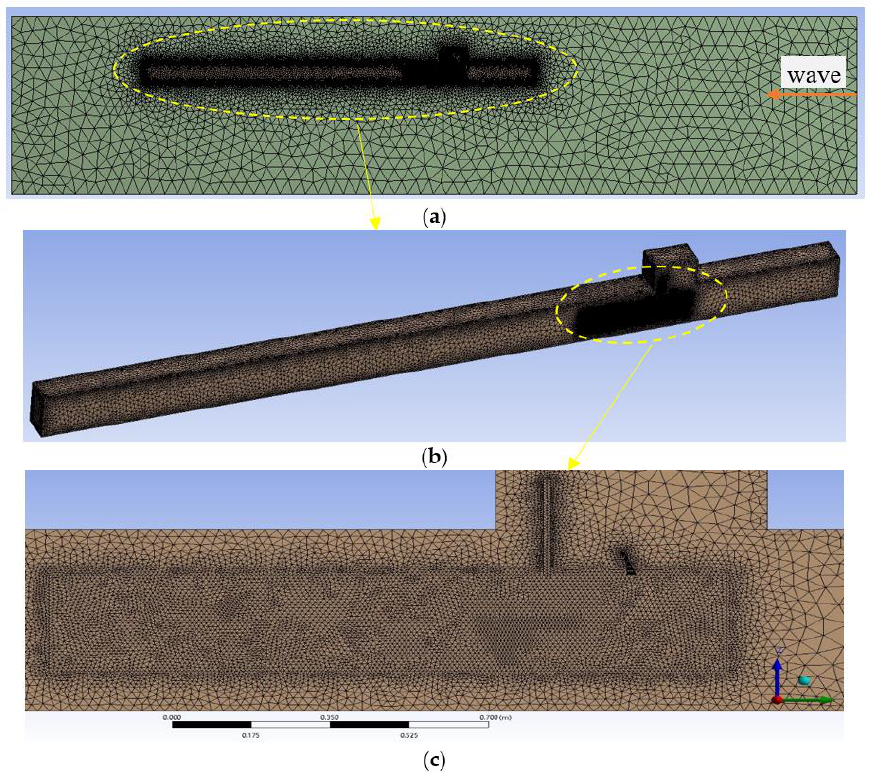
Figure 10. Meshing of the simulation domain: ( a ) 2D sectional view of the domain; ( b ) 3D view of the intermediate denser mesh region; ( c ) 2D sectional view of the core denser mesh region (the box ship with flat plate and breakwater).